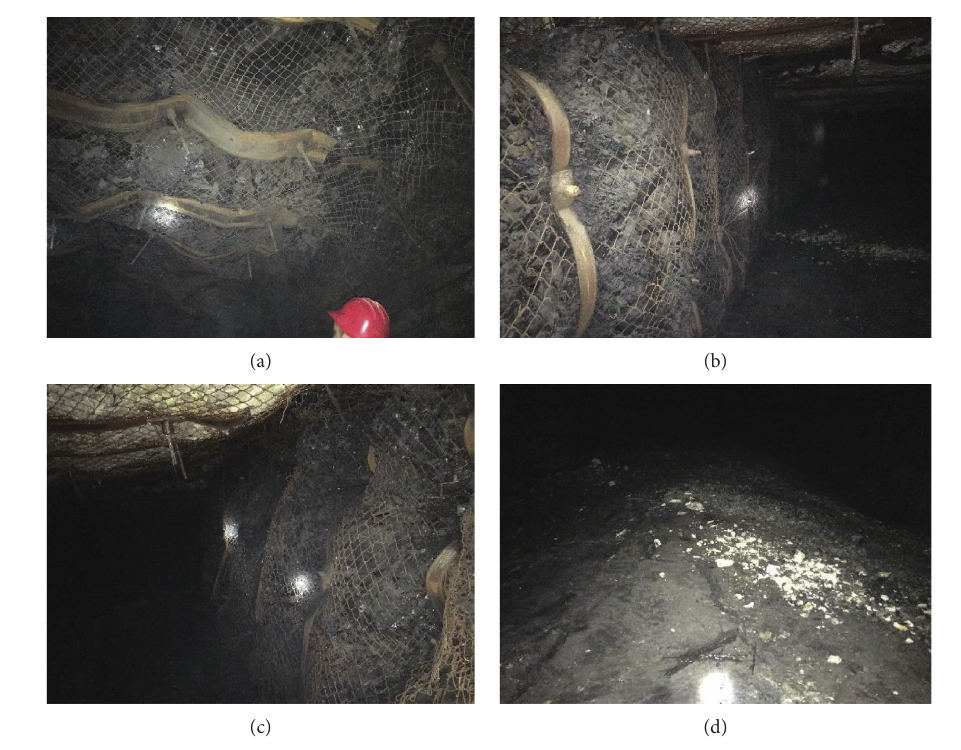
Figure 2: Instability characteristics of haulageway.